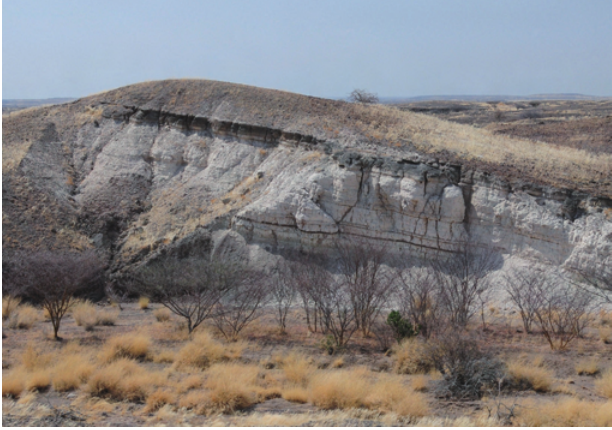
Figure 3. Outcrop photo of Middle Pliocene laminated diatomites from near the depocenter of a paleolake in the Northern Afar, one of the likely target locations and intervals for HSPDP drilling. Hill is about 8 m